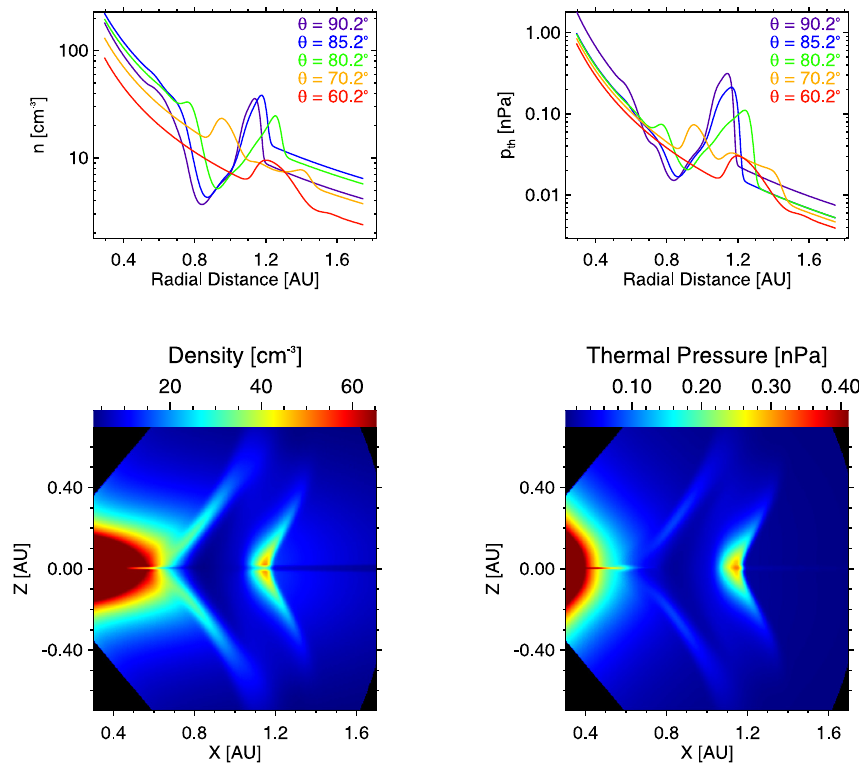
Fig. 11. Density (left) and thermal pressure (right) for the H − m magnetic cloud near